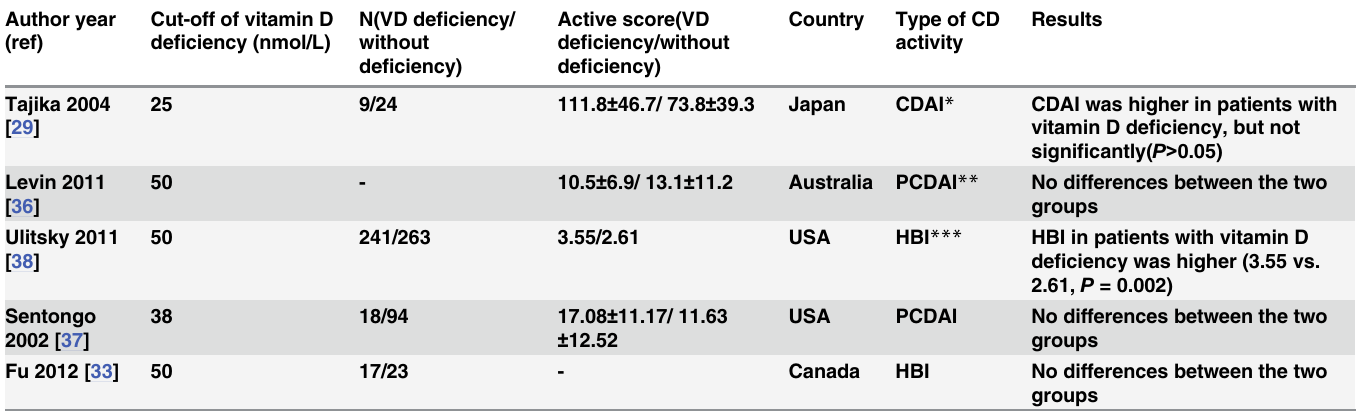
Table 4. Data for dichotomous variable group on vitamin D deficiency and CD